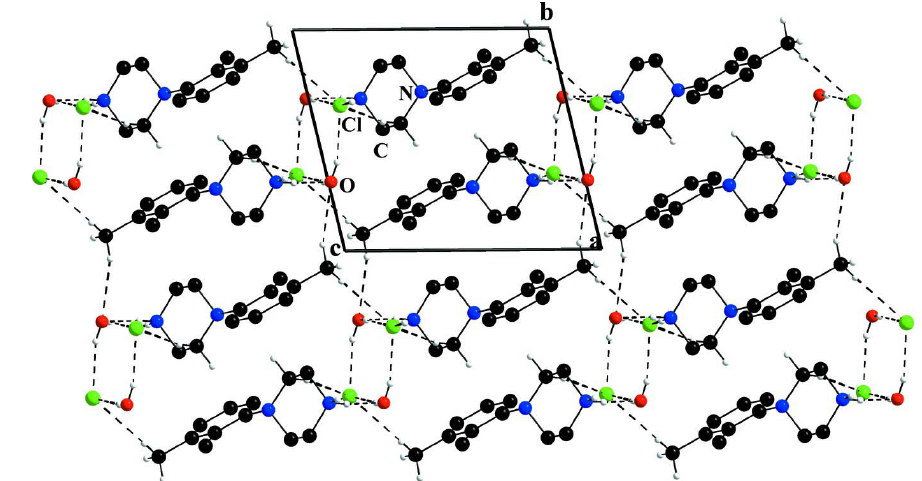
Figure 2 The packing of (I), viewed down the a axis, showing the O—H···Cl, N—H···Cl, N—H···O, C—H···O and C—H···Cl interactions (dashed lines) between the 4-(2,3-dimethylphenyl)piperazin-1-ium cation, water molecule and chloride